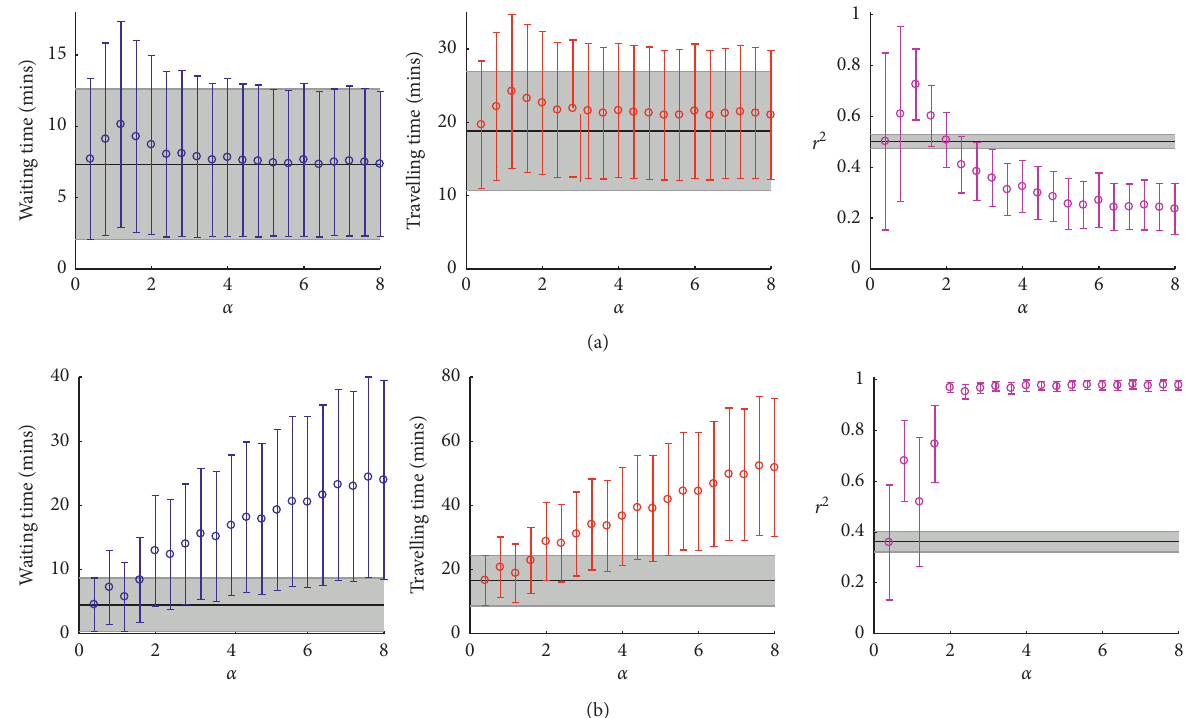
Figure 11: Results of simulating the s-holding strategy in the two different-velocity scenarios. Each colored point represents the mean and standard deviation of the measured quantities calculated from 100 realizations of each parameter value. The black line and grey shaded area of each graph denote the mean and standard deviation of the measured quantities from a control case, which are simulation runs of the same parameter values, without any intervention strategies. (a) S-holding strategy in lull-different. (b) S-holding strategy in